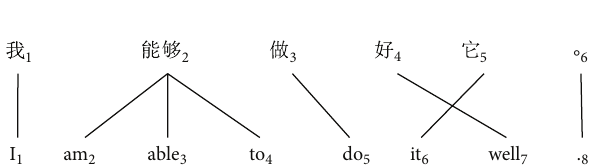
Figure 1: Full word alignments.